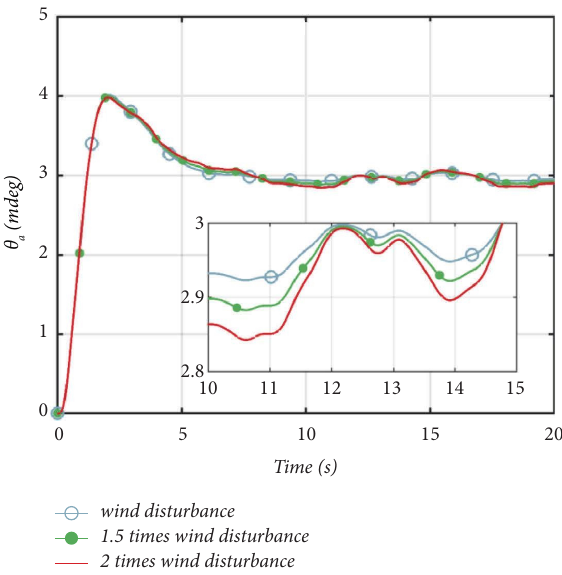
Figure 19: Te step response of the PI controller when wind disturbance is increased.